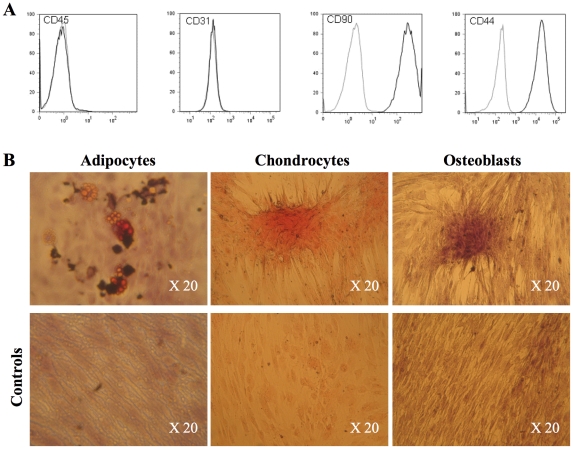
Characterization of ASCs.(A): Flow cytometric analysis after the 3rd passage of porcine ASCs labelled with FITC- or PE-conjugated control isotype IgG (bold curves) or antibodies against indicated cell surface proteins (dark curves). (B): Differentiation of ASCs cultured in specific media.